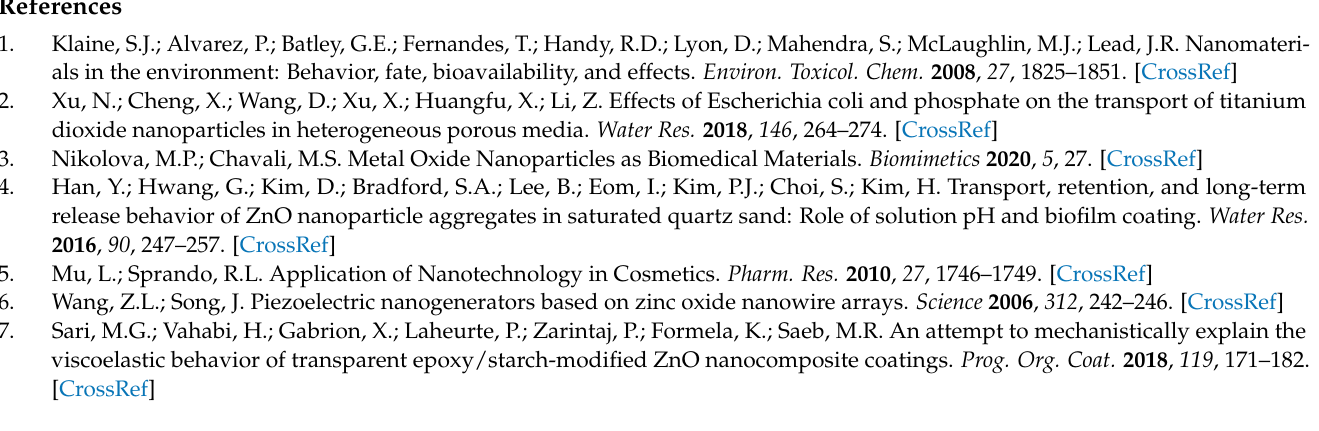
Figure S3: Specific surface areas of two types of n ZnO from Brunauer-Emmet-Teller (BET) method, Figure S4: DLVO interaction energy profiles of n ZnO-1 for NPs–NPs (solid line) and NPs–sand (dashed line) surfaces in NaCl (1–10 mM) solutions in the absence/presence SRHA, Figure S5: DLVO interaction energy profiles of n ZnO-2 for NPs–NPs (solid line) and NPs–sand (dashed line) surfaces in NaCl (1–10 mM) solutions in the absence/presence SRHA, Table S1: Parameters used to calculate DLVO interaction energy profiles, Table S2: Mass balance for two types of n ZnO in column